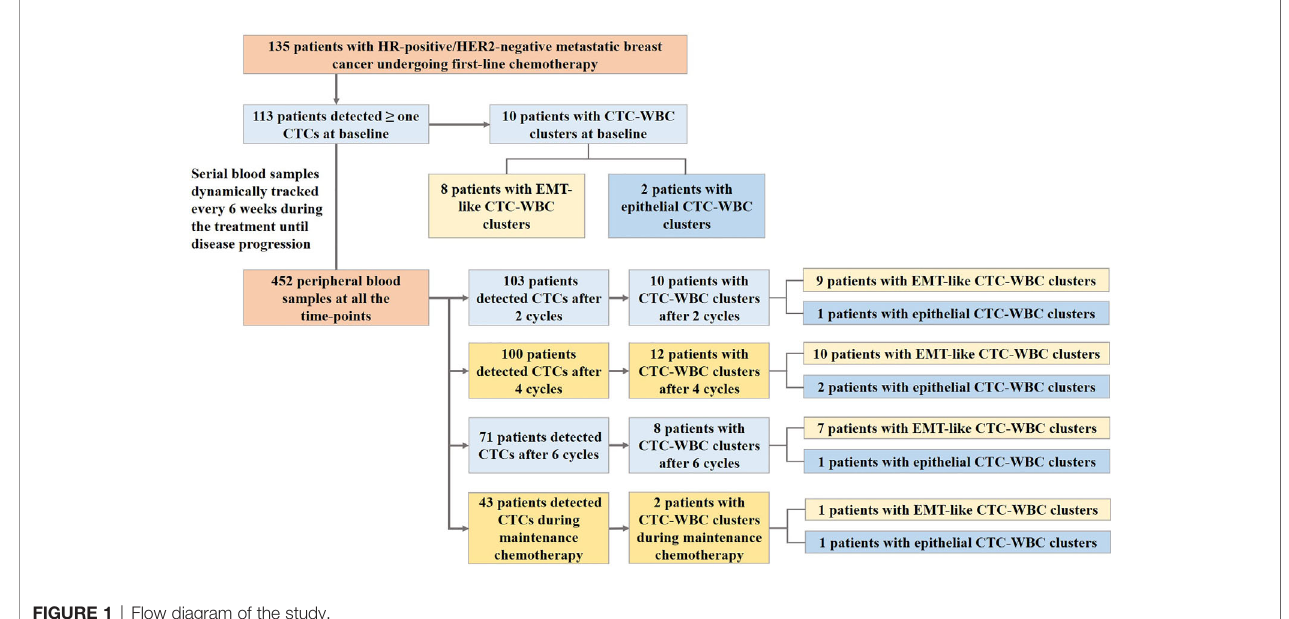
FIGURE 1 | Flow diagram of the study.